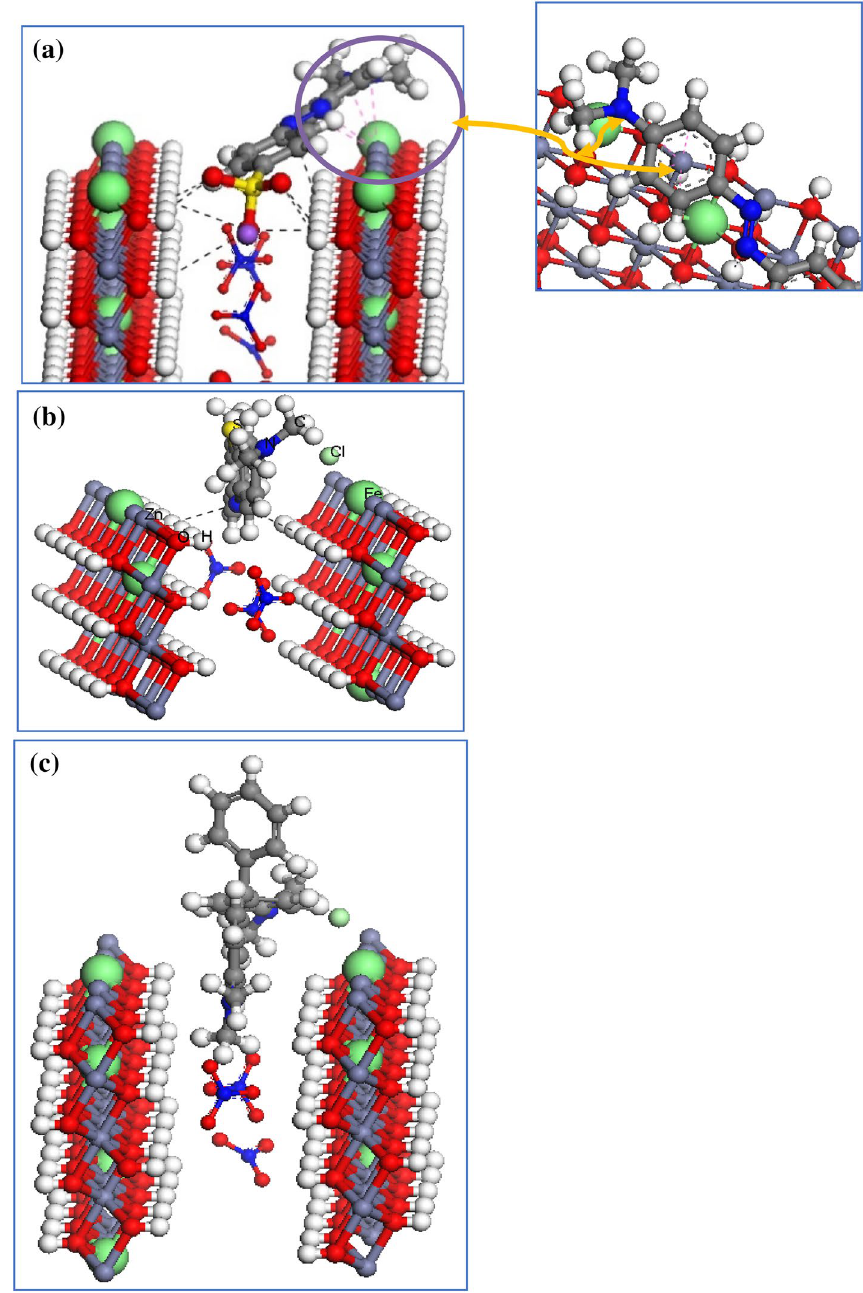
Figure 17. The adsorption of MO ( a ), MB ( b ), and MG ( c ) molecules on the Zn–Fe LDH (010) surface, as obtained from the MC